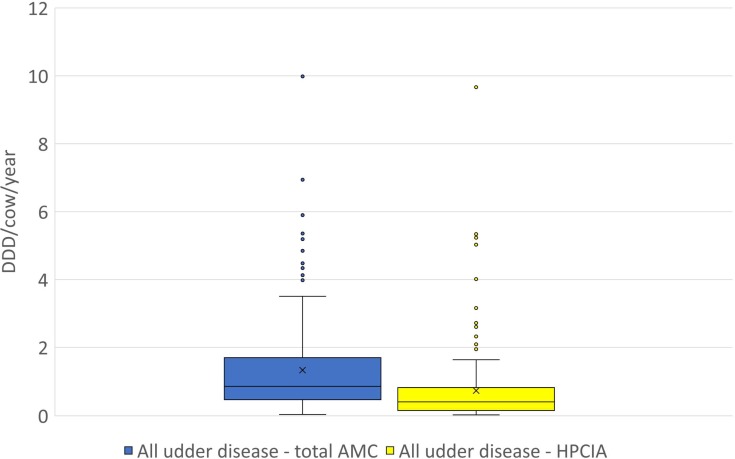
The distribution of the number of Defined Daily Doses (DDDvet) per cow and year by individual herd for all reported diagnoses of “udder disease”—for total AMC and for HPCIA.AMC, antimicrobial consumption; HPCIA, highest priority critically important antimicrobials. Box, the range between the 1st (Q1) and 3rd (Q3) quartile; horizontal line, median; x, mean; lower whisker, Q1−1.5(IQR) (interquartile range); upper whisker, Q3 + 1.5(IQR); dots, outliers.